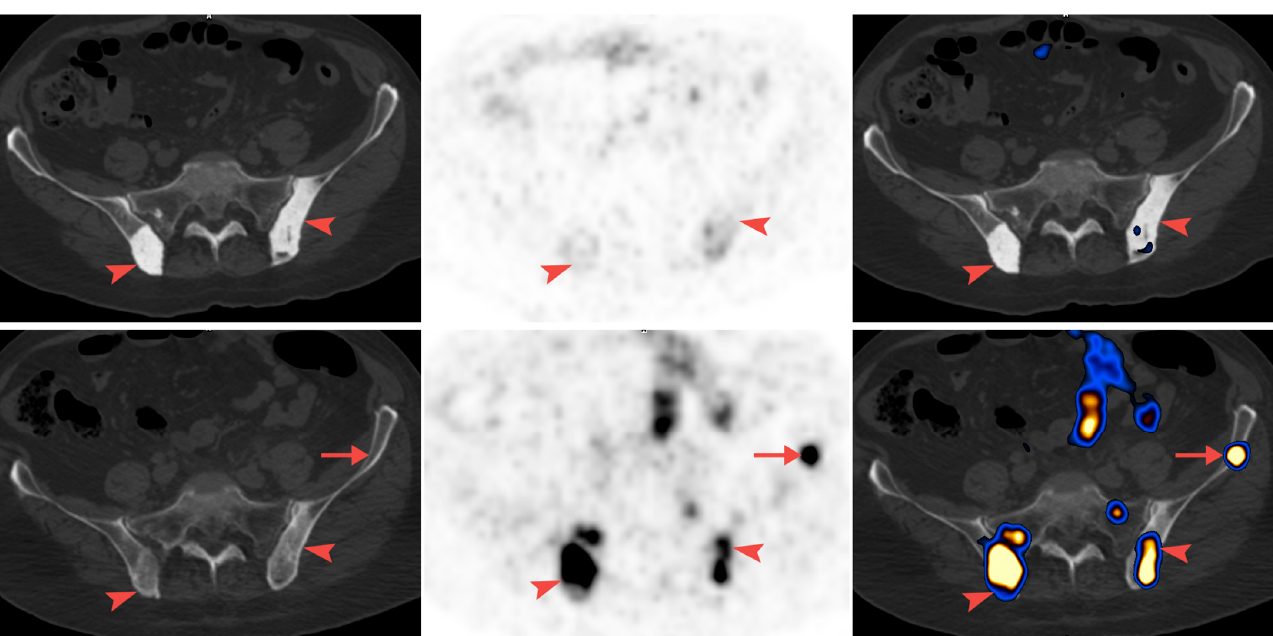
Figure 1. Disease response (Patient 7). (From left to right) CT; PET; and fusion images. In the first scan after ADT and bisphosphonate treatment, sclerotic metastasis in the vertebra was identified with very low uptake of 68Ga-PSMA-11 (arrowhead) (top row). In the second scan after ADT, the vertebra was no longer sclerotic and showed no uptake (bottom row). PSA levels were reduced and there was no evidence of new disease.